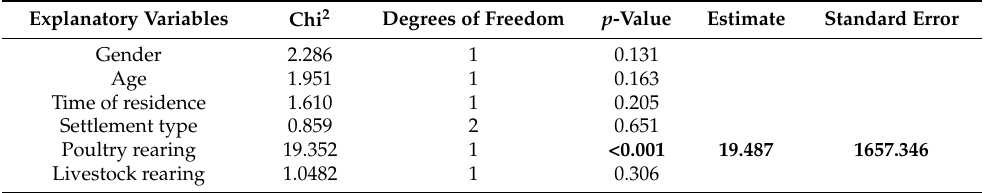
Table 7. Deviance analysis results showing the effect of each factor used in the binomial generalized linear model for the response variable conflicts with Roadside Hawks and their significance, per- formed with the Anova function of “car” package. Explanatory variables with p -values <0.05 are in bold. The estimated coefficient and standard error are shown for the significant category (yes) of the significant social